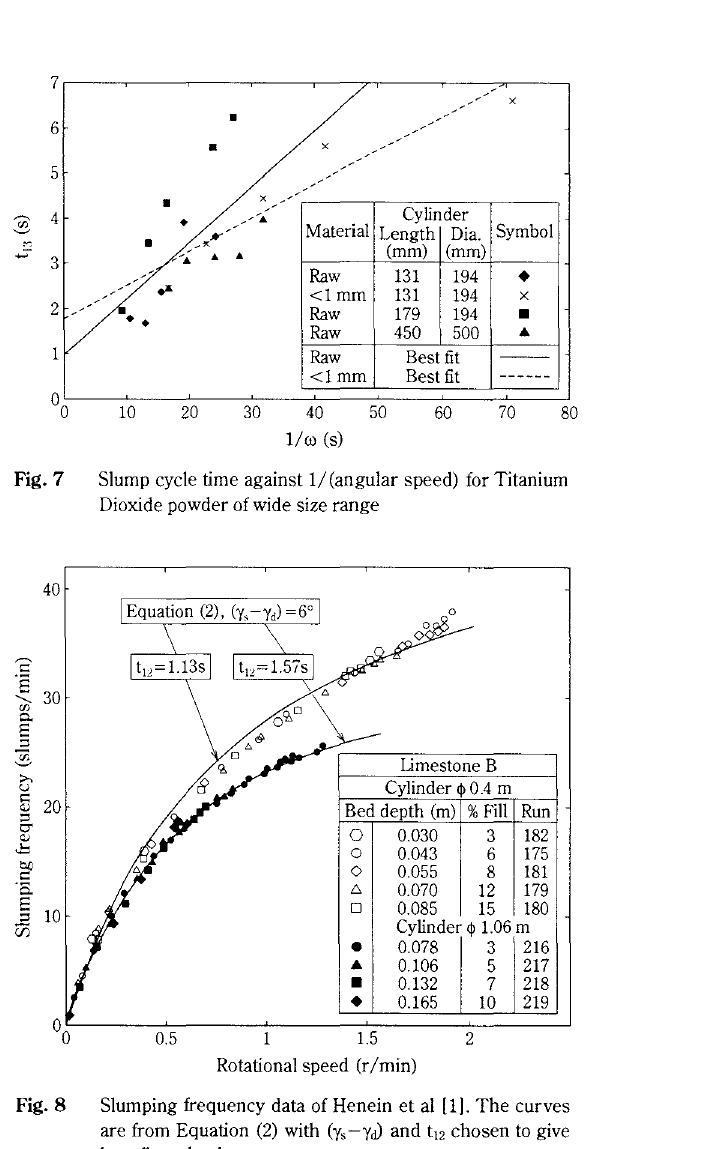
Table 1 Avalanche times t12 for sand from Figures 4-6 on the basis of Equation (1) Figure